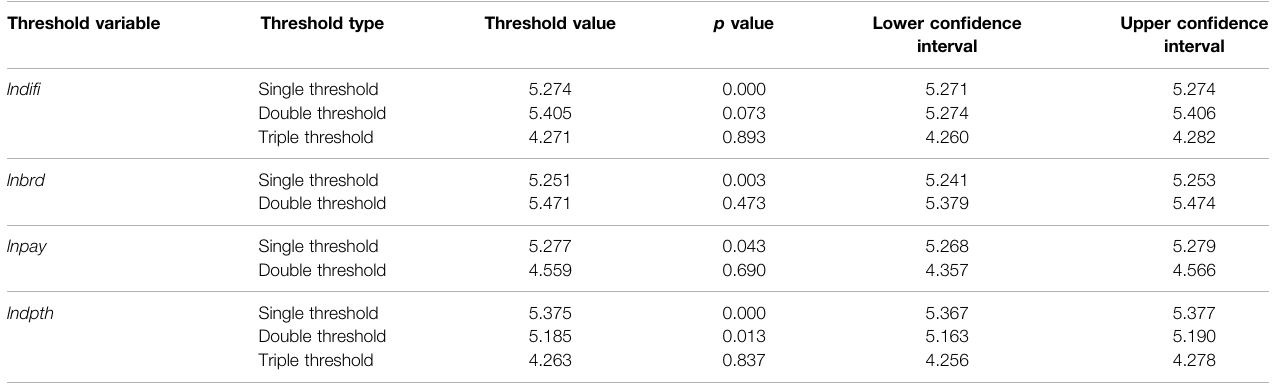
TABLE 7 | Threshold effect test.